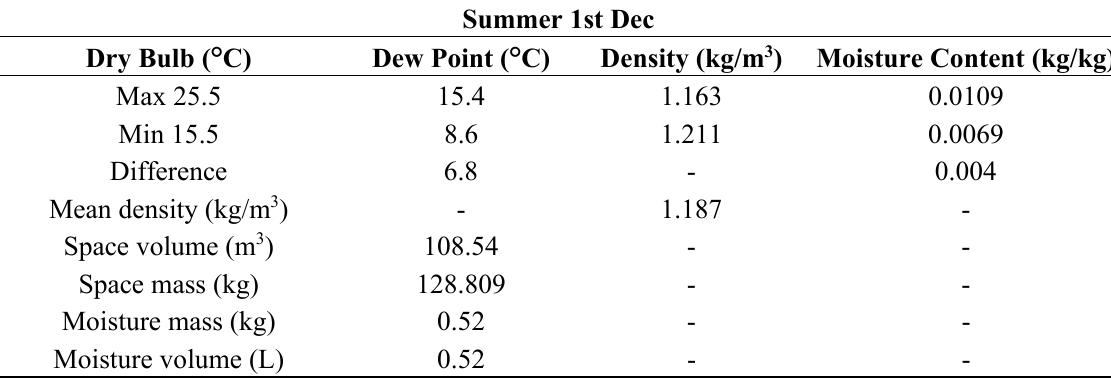
Table 7. Data for estimation of the moisture volume being evaporated and